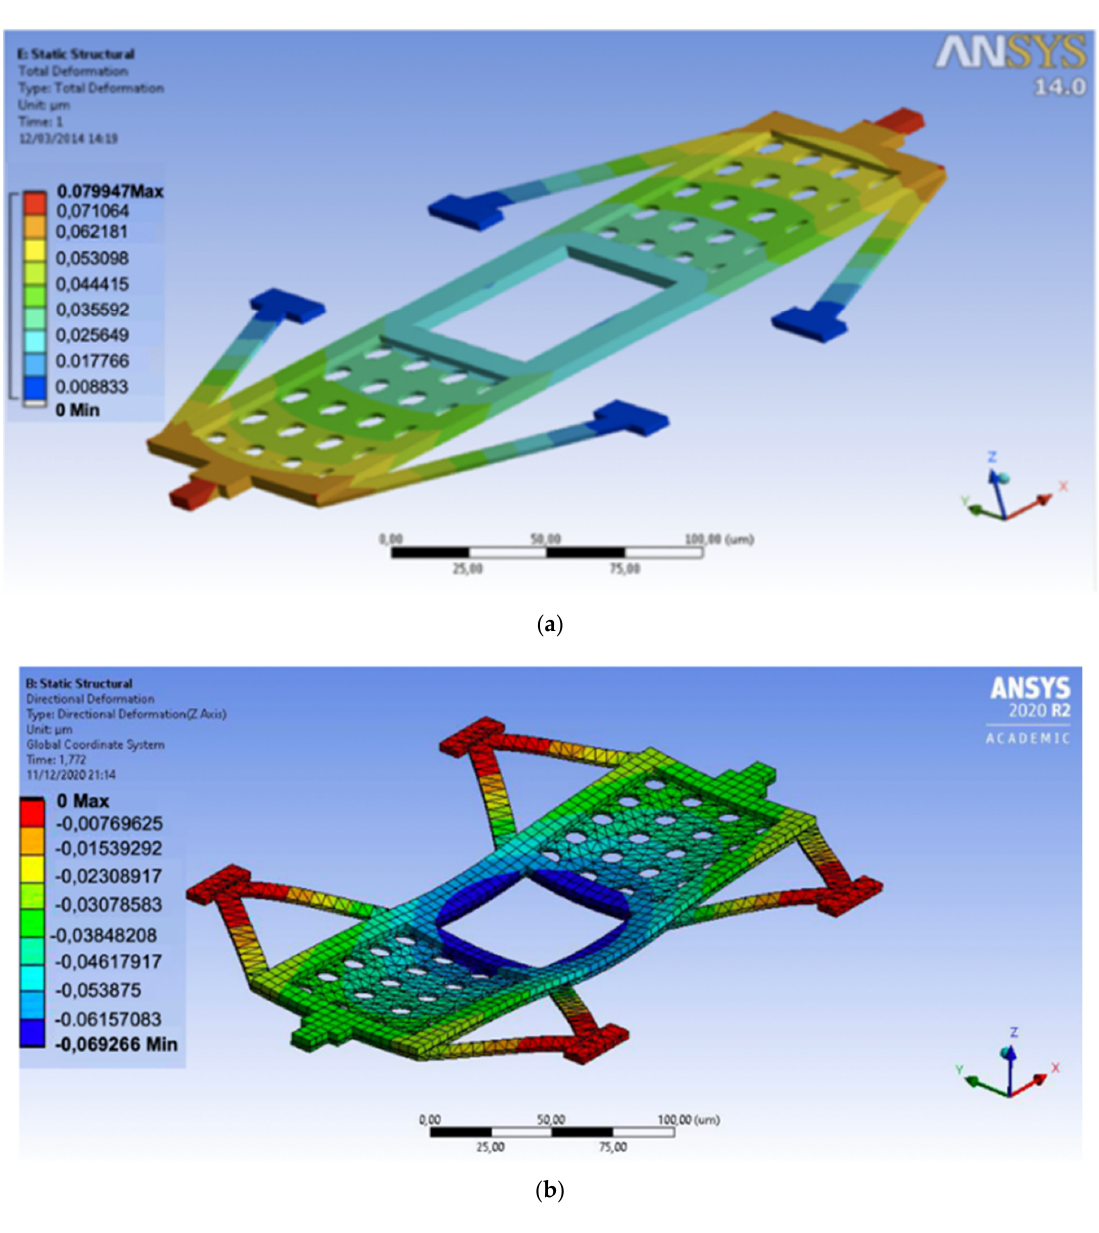
Figure 10. Initial deformation due to residual stress. ( a ) DG suspension; ( b ) DDG suspension. Figure 11 shows the hysteresis measurements (magnitude of the transmission coeffi ‐ cient |S 21 |(dB) vs. actuation voltage) of the bridge ‐ type switches shown in Figure 1, from which the actuation voltages (V pull ‐ in ) and the release voltage (V pull ‐ out ) can be easily in ‐ ferred. The measurement frequency was 10 GHz. The measured values for V pull ‐ in are given